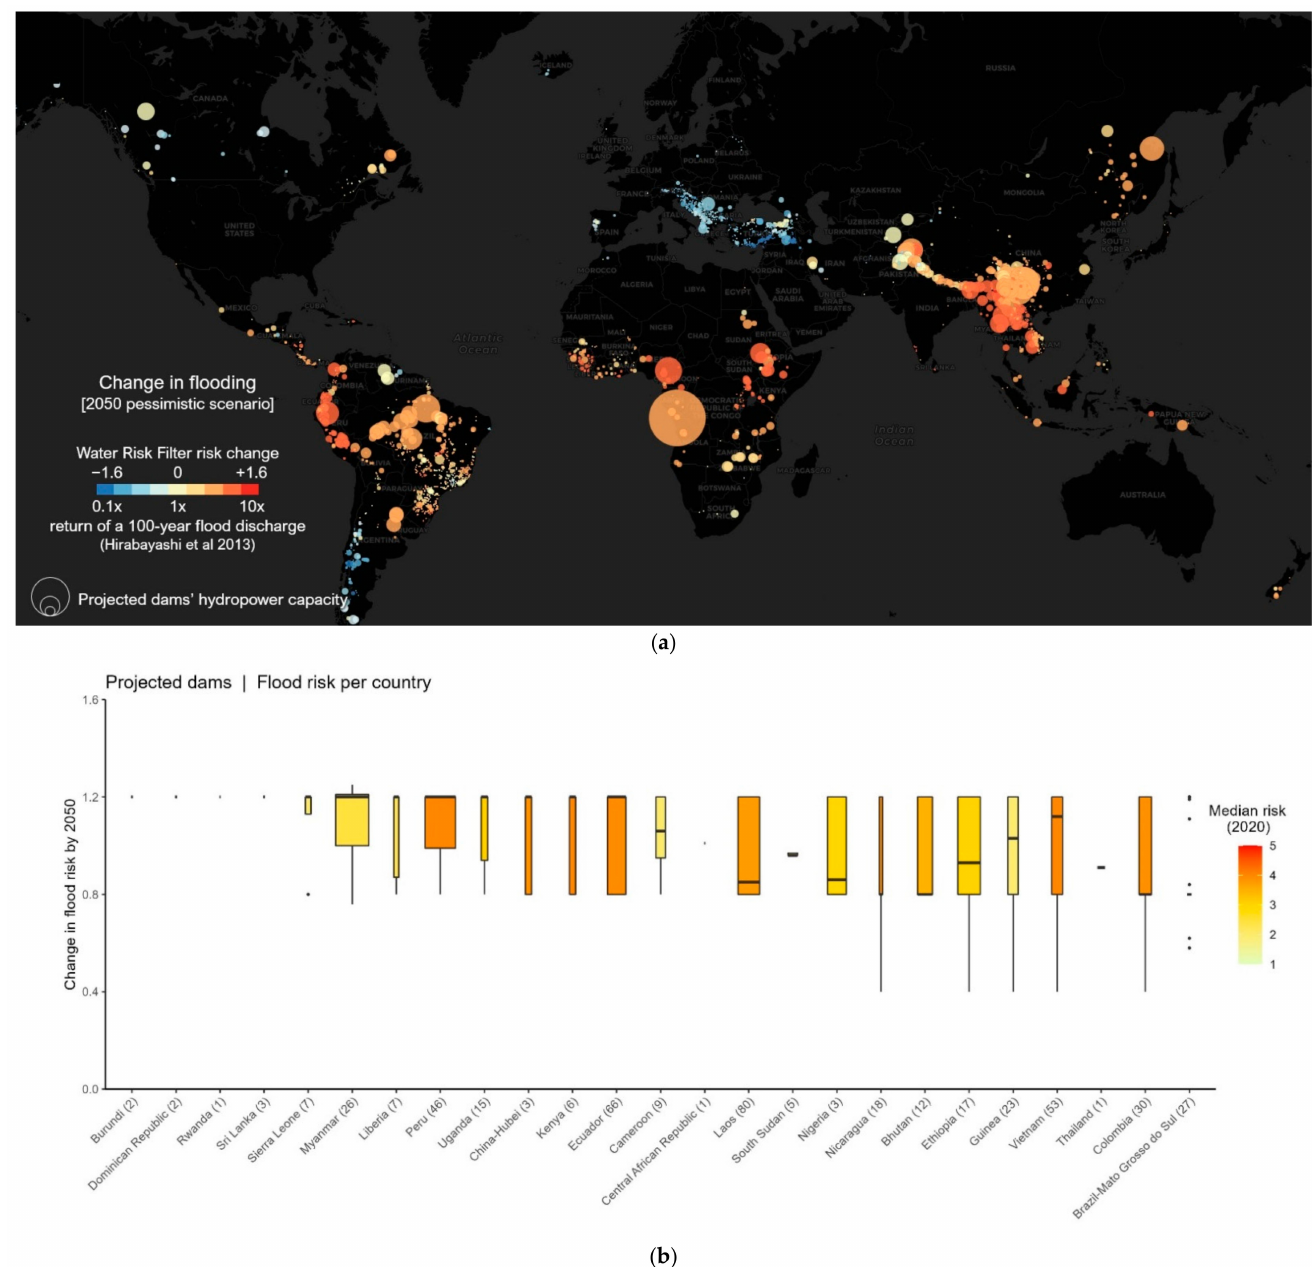
Figure 10. ( a ) Distribution of projected hydropower dams with color indicating the projected change in relative flood risk in 2050 under the pessimistic scenario. The size of the circle re- flects the hydropower capacity of the dam. See the interactive version of this map at https: //rcamargo.shinyapps.io/HydropowerClimateChange; (accessed 21 January 2022). ( b ) Change in flood risk (vertical axis) for the basins of projected hydropower dams by 2050 according to country or subnational region under the pessimistic scenario. Bar color indicates current risk and width indicates aggregate hydropower